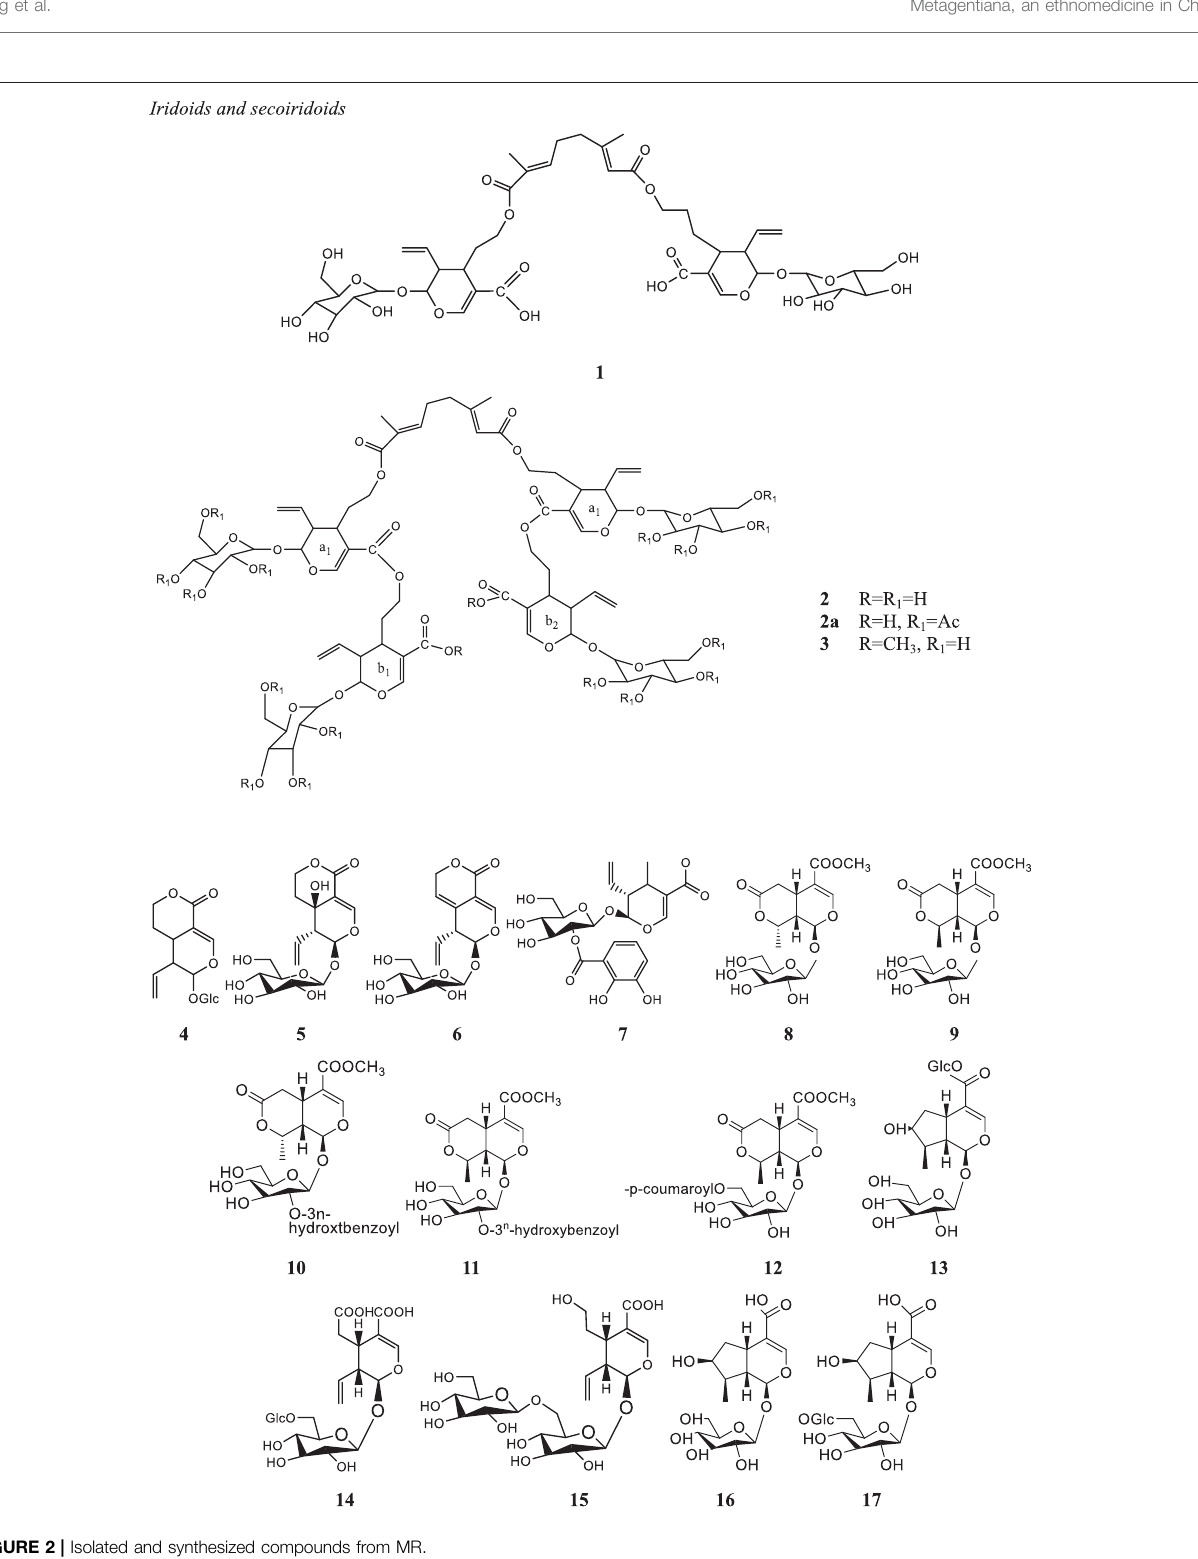
FIGURE 2 | Isolated and synthesized compounds from